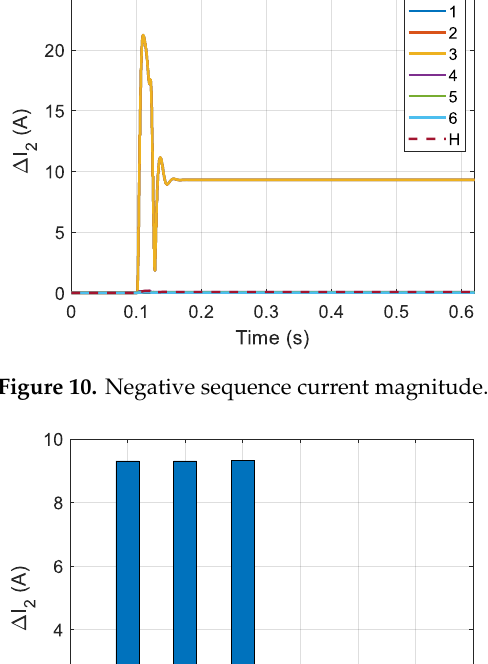
Figure 11. Negative sequence current magnitude.